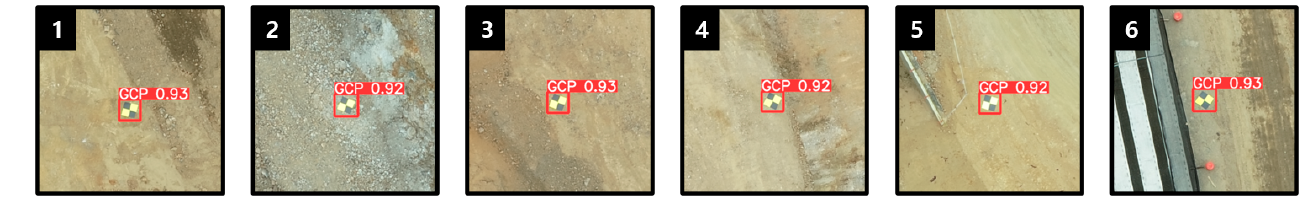
Figure 8. Detection results of six GCPs in orthophoto.